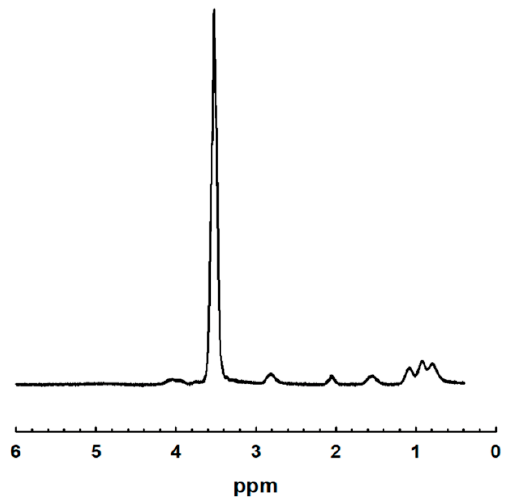
Figure 4. NMR structure of WSPU.